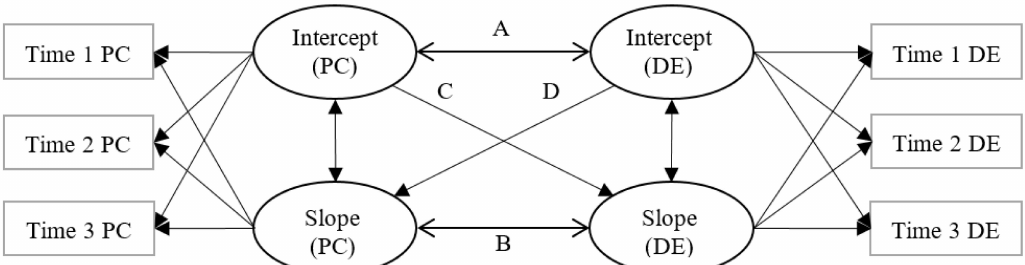
Figure 1. Parallel-process latent growth curve models for parental control (PC) and adolescent delinquency (DE). Error terms and covariates were not shown in the figure. A: cross-sectional associations between baseline PC and baseline DE. B: parallel associations of changes in PC with changes in DE. C: prospective predictions of baseline PC on change rate of DE. D: prospective predictions of baseline DE on change rate of